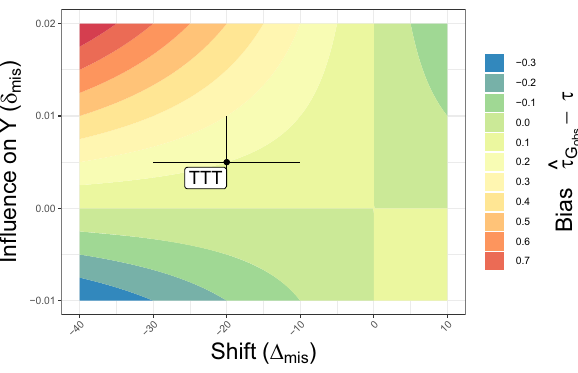
Figure 11: Sensitivity map for TTT : Intervals represent plausible parameters range, with a treatment given on average 10 – 30 min earlier in the Traumabase, and an heterogeneous coe ffi cient inspired from [ 66